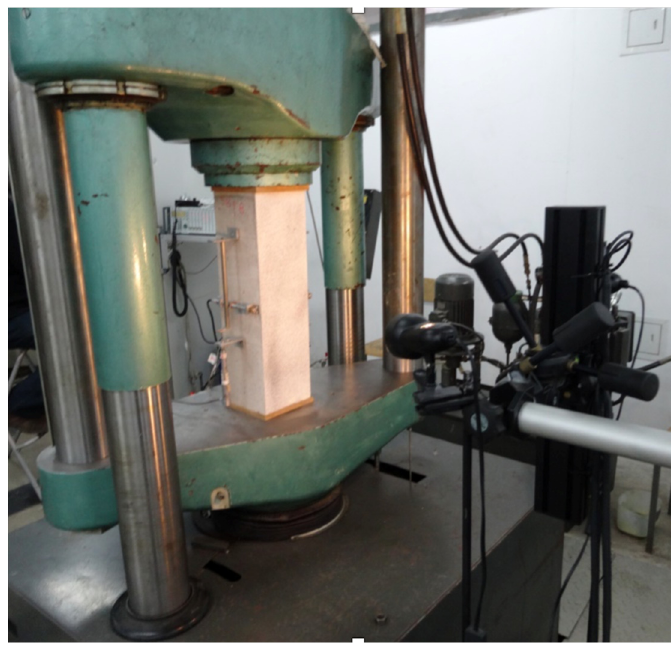
Figure 2. Test stand with the sample prior to the test.